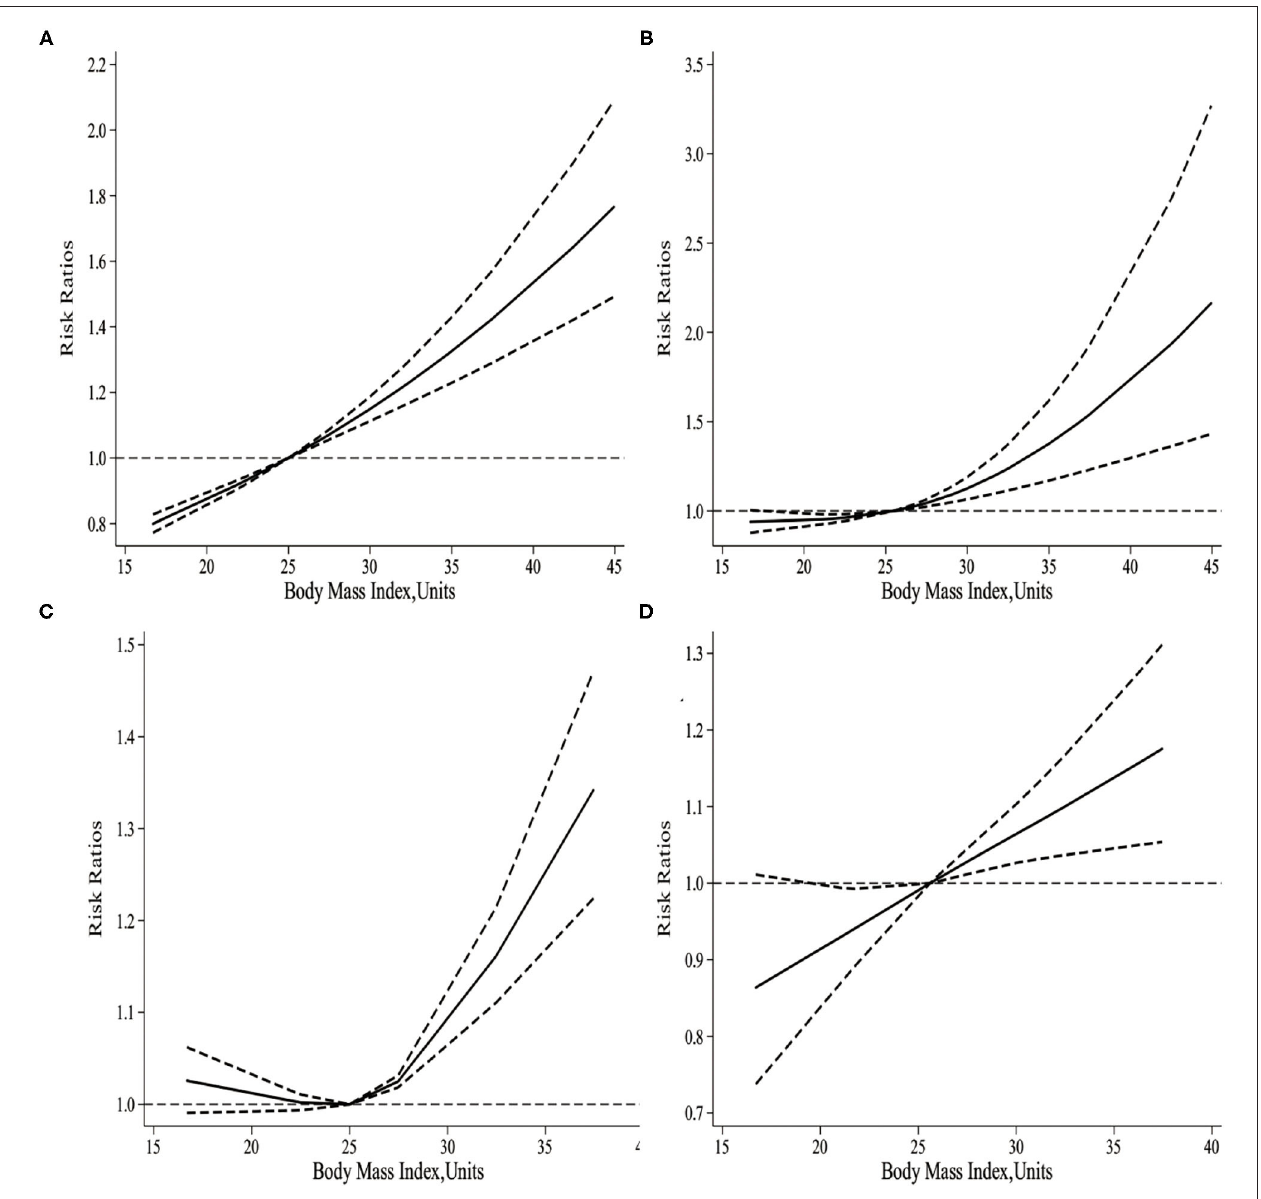
FIGURE 3 | (A) The dose-response of maternal BMI and the risk of infant mortality. (B) The dose-response of maternal BMI and the risk of neonatal mortality. (C) The dose-response of maternal BMI and the risk of post-neonatal mortality. (D) The dose-response of maternal BMI and the risk of early neonatal mortality.